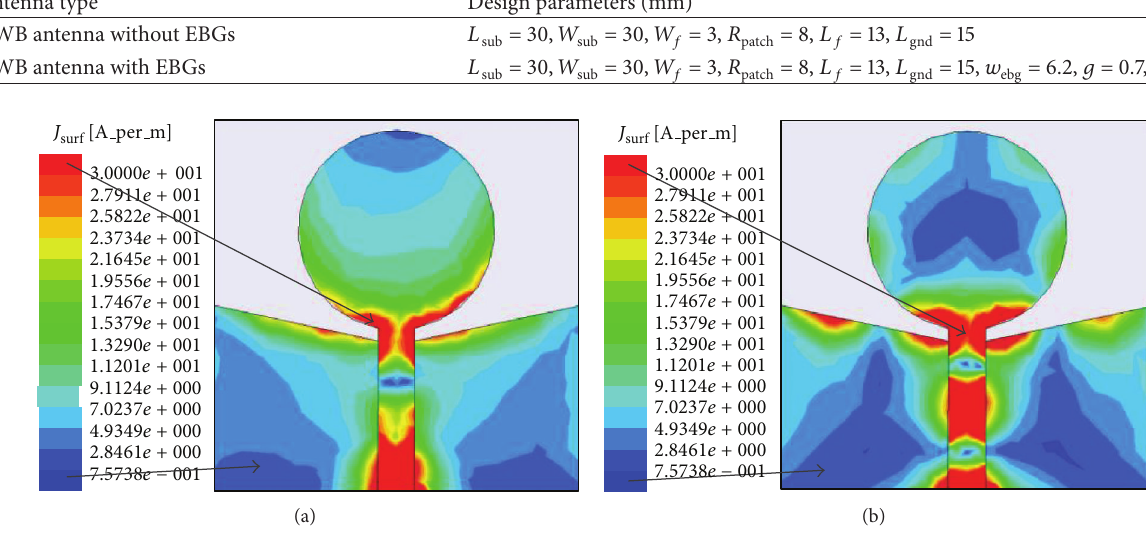
Figure 4: Current distribution on single UWB antenna without EBGs at (a) 4GHz and (b)